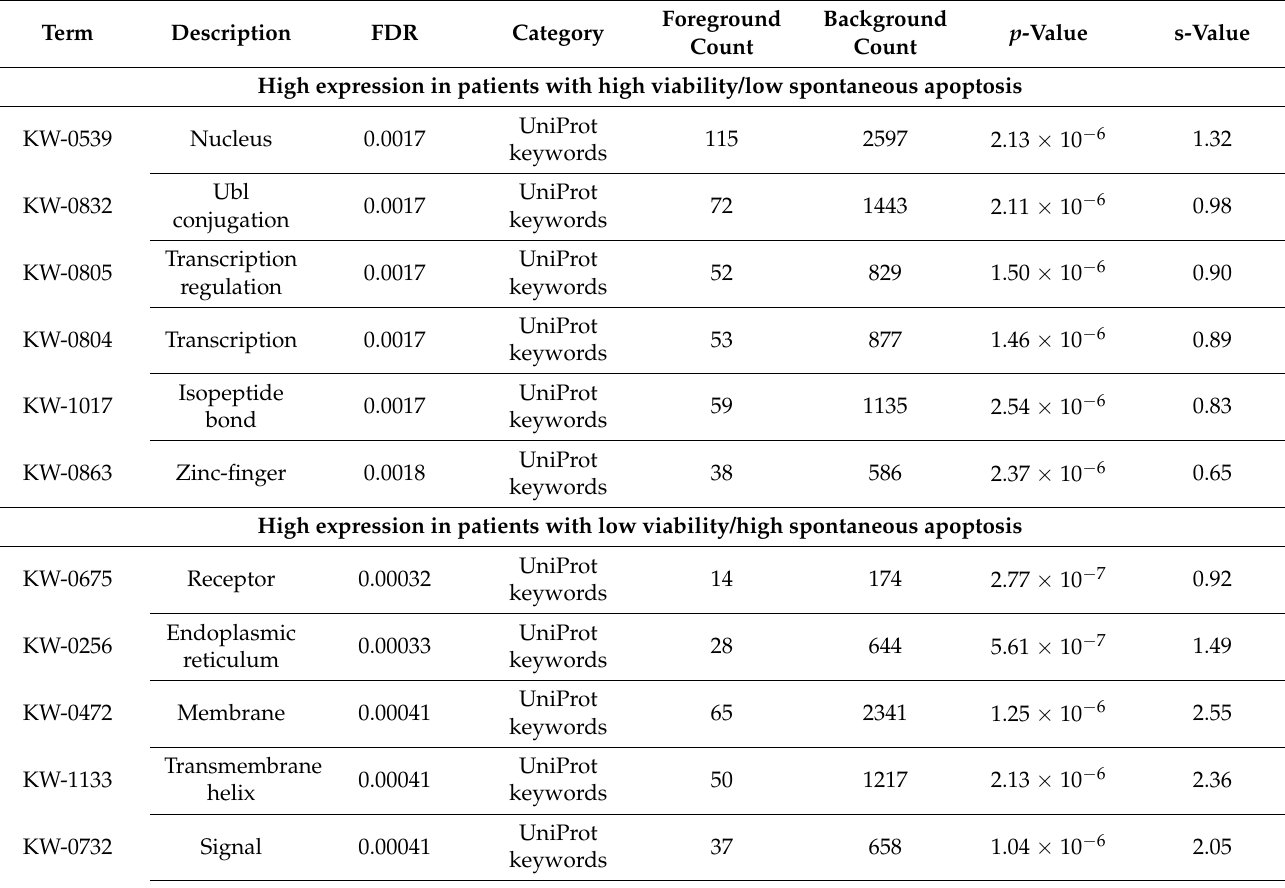
Table 2. Classification of proteins showing differential expression when comparing AML cells with high (i.e., >25% viable cells) and low viability after in vitro culture using a GO tool. We identified 276 proteins with significantly different levels, and the table presents the six terms for each of the two patient subsets with the lowest false discovery rate (FDR) when analyzing GO cellular component/cellular component text mining, GO biological process, GO cell components, GO molecular function, KEGG pathways, Reactome pathways, and UniProt keywords. The table presents the description of each term together with foreground and background counts, p - and s-values. S-value is a combination of (minus log) p value and effect size (i.e., positive associations in the foreground divided by all associations); a positive value indicates overrepresentation of a given term, and a negative value indicates underrepresentation of a given term. Foreground counts indicate the number of positive associations in a given cluster for a given term (i.e., the number of proteins associated with the given term) and background counts indicate the number of positive associations in the dataset. The proteins were ranked based on the FDR and the table presents the six highest ranked terms for each